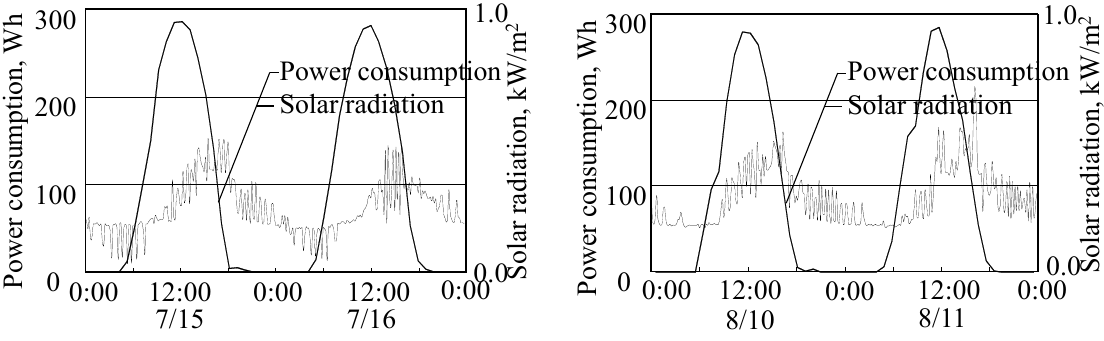
Figure 4. Measurement results for cooling energy consumption and solar radiation. left : Before painting; right : After